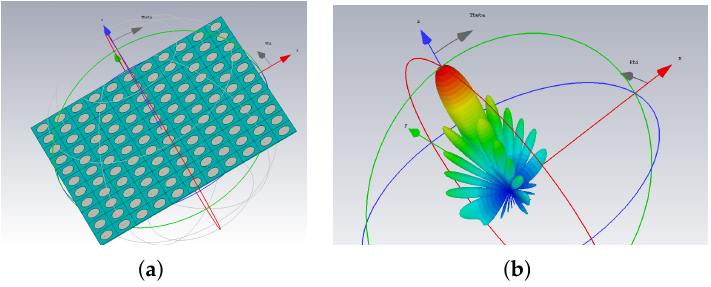
Figure 3. Figure ( a ) shows the model of the antenna array in CST Studio, while picture ( b ) plots the directivity pattern of the proposed antenna